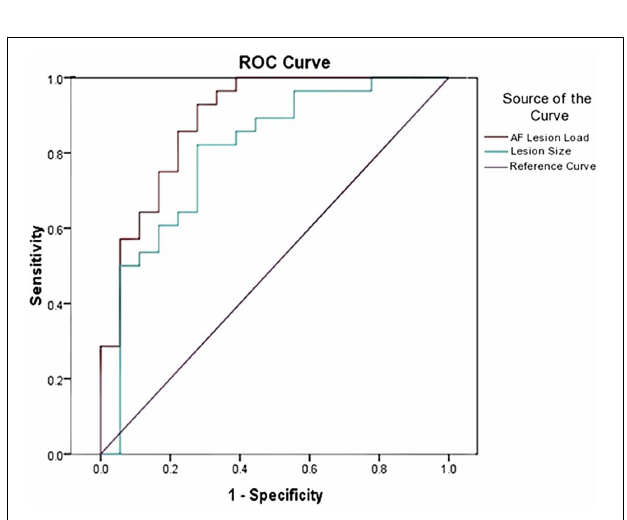
FIGURE 6 | Naming Ability ROC curve shows prediction from AF-LL and lesion volume for naming ability. AF-LL was best at predicting naming with 90% accuracy, and a threshold for severe group at 4